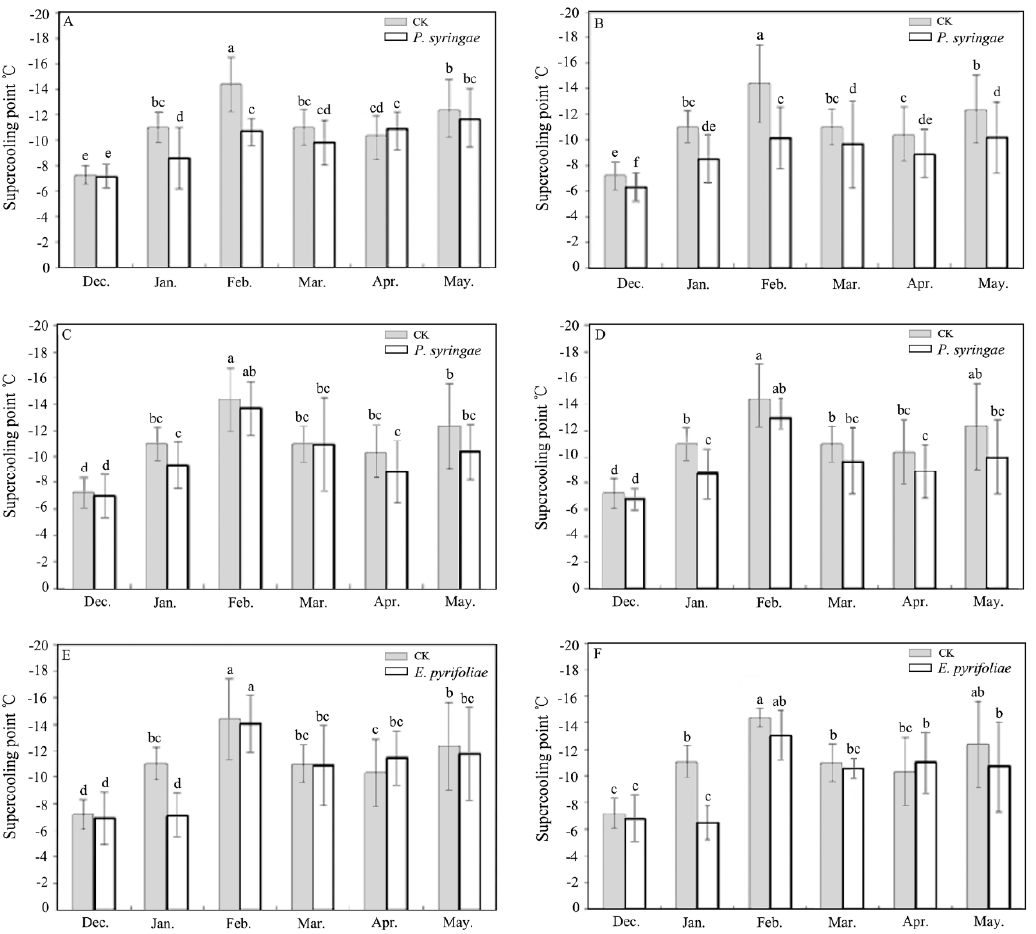
Figure 2. Effect of INA bacteria ( P. syringae 1.3200; P. syringae 1.7277; E. pyrifoliae 1.3333) on the SCP of E. extimalis at different times. ( A , C , E ): bacterial concentration = 0.1 OD; ( B , D , F ): bacterial concentration = 0.3 OD. Results are shown as the mean ± SD. Letters on the error bars indicate significant differences analyzed using the one-way analysis of variance (ANOVA) with Tukey’s test ( p <